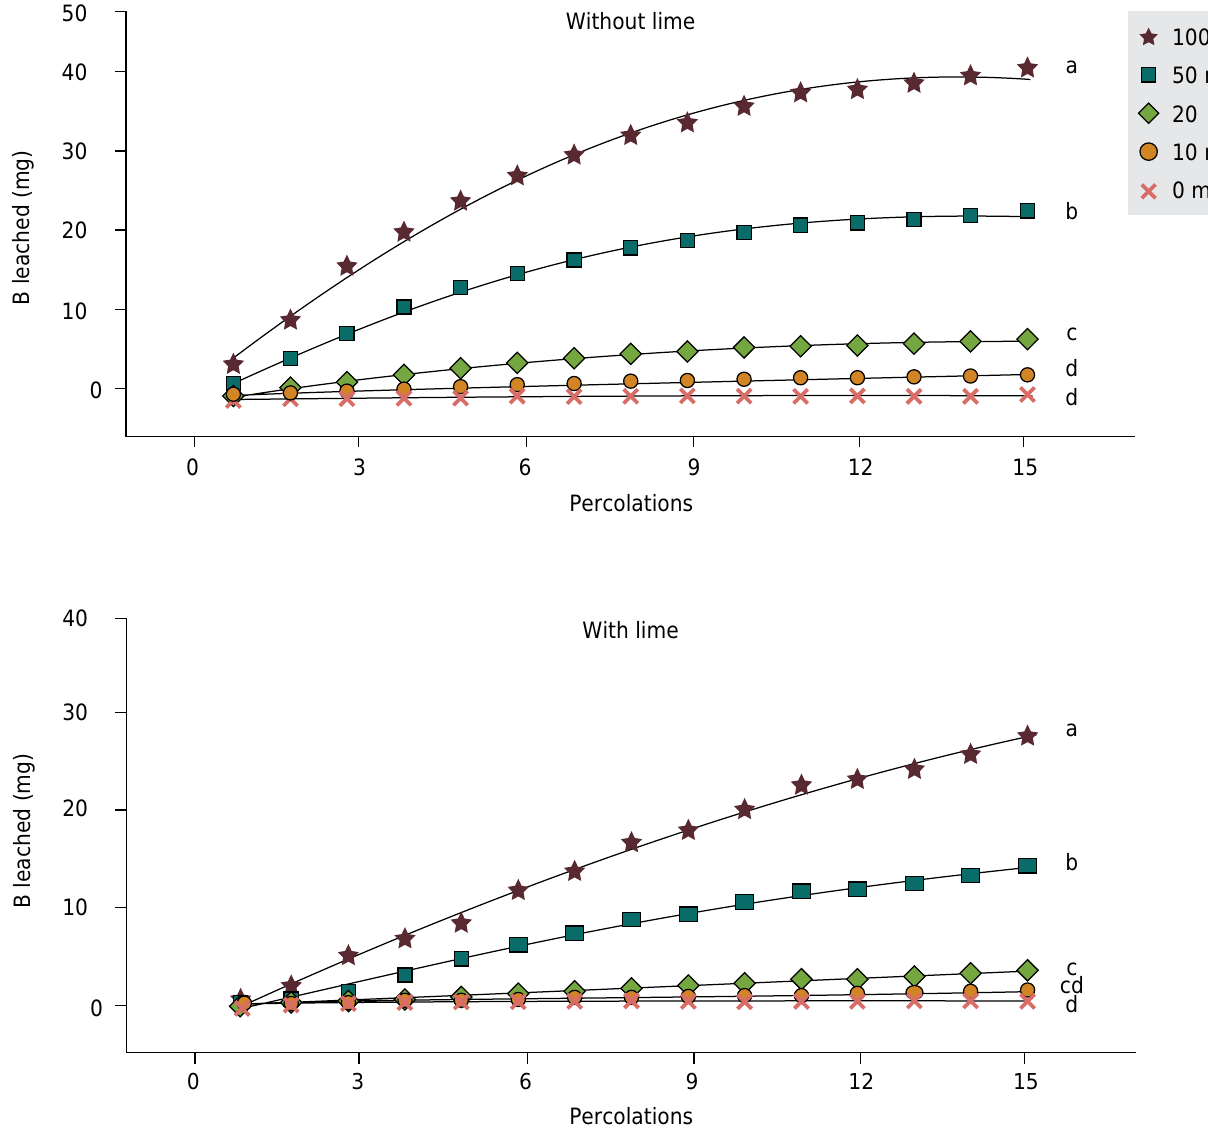
Figure 2. Cumulative boron leached during 15 percolations with distilled water as affected by liming and rates of boron applied. Average of three replications. Total cumulative values followed by the same letter are not different by the Tukey test at the 5 % significance